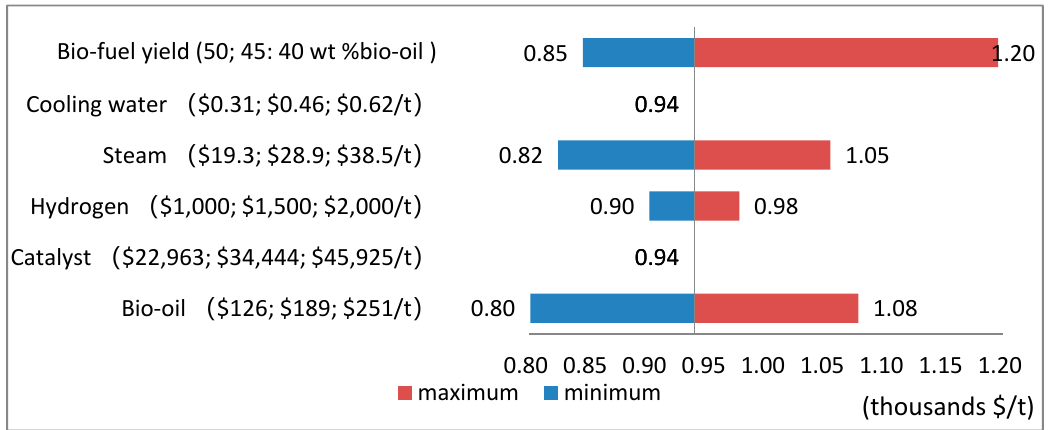
Figure 6. Sensitivity analysis for the ideal production costs.